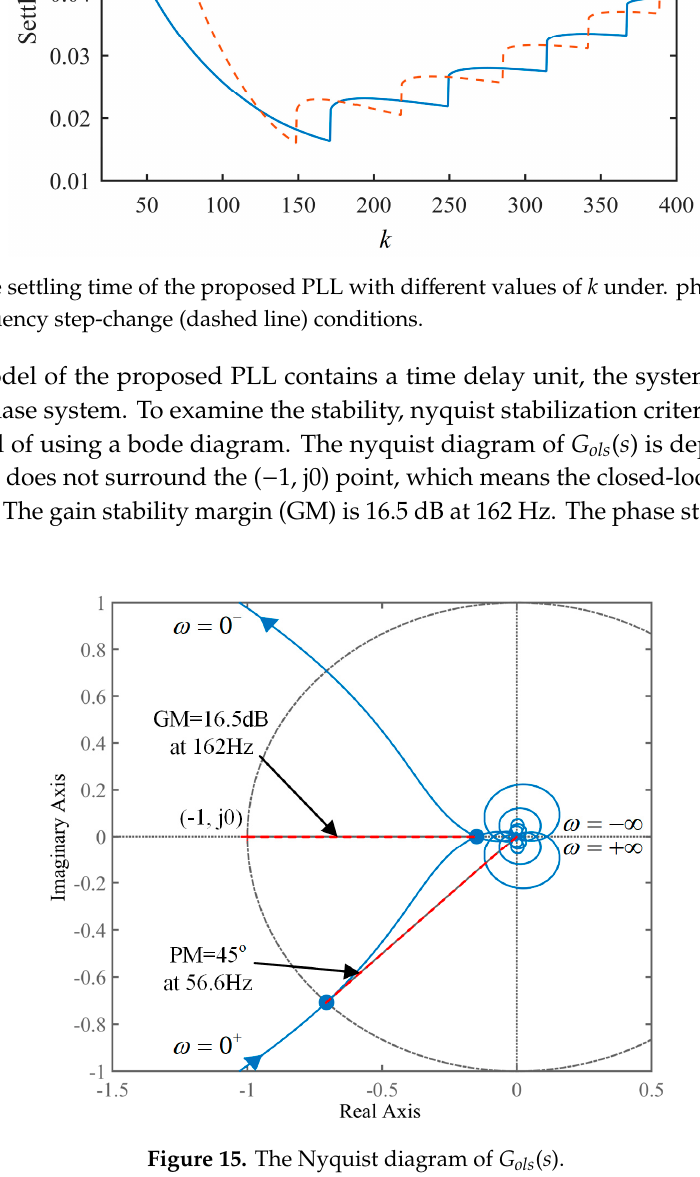
Figure 15. The Nyquist diagram of G ols ( s ).